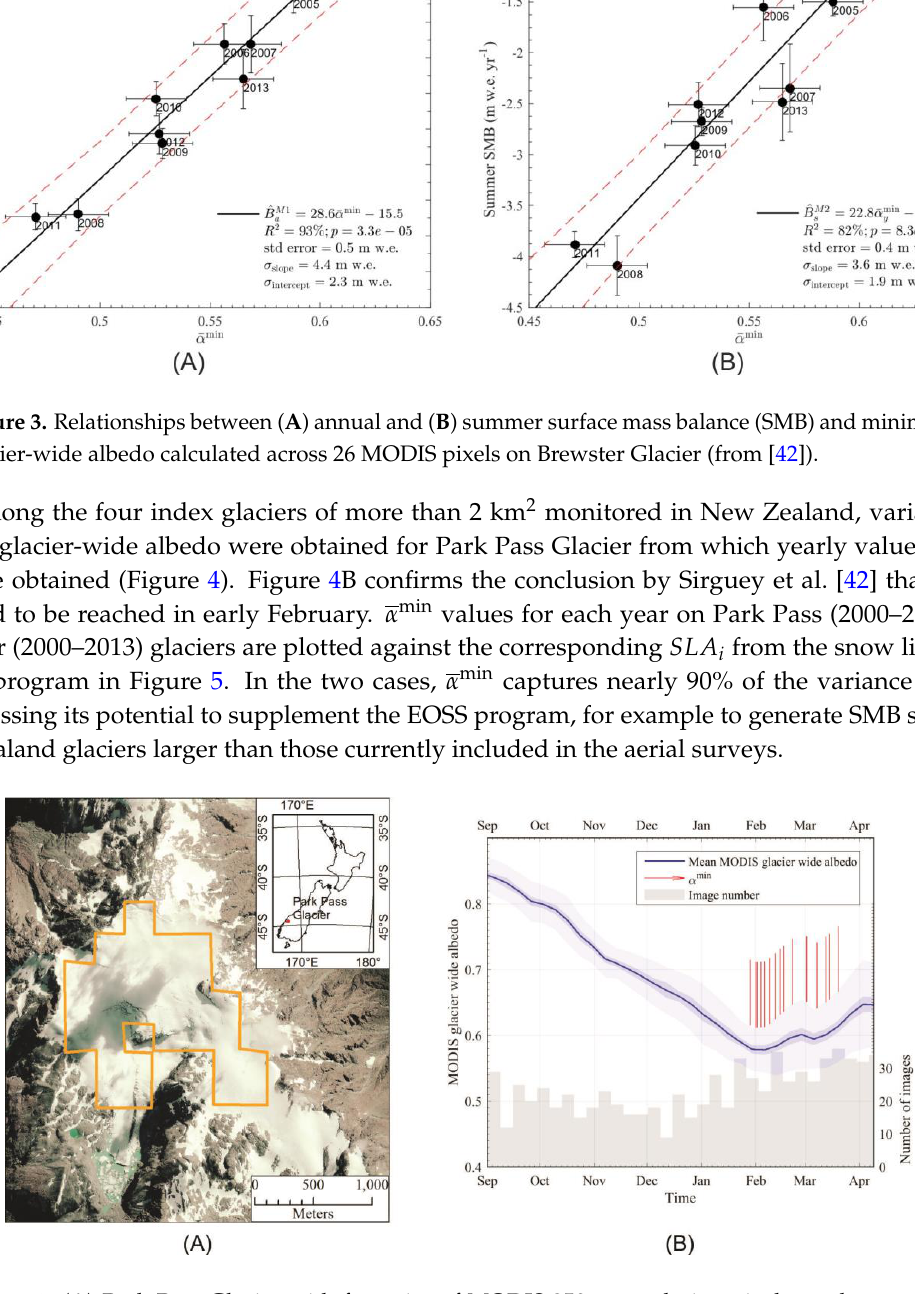
Figure 4. ( A ) Park Pass Glacier with footprint of MODIS 250-m resolution pixels used to retrieve glacier surface albedo; ( B ) average seasonal albedo cycle of Park Pass Glacier for the 2000–2015 period. Retrieval of albedo is compromised during winter months as the glacier is almost fully in the shade at the time of MODIS/Terra acquisition.